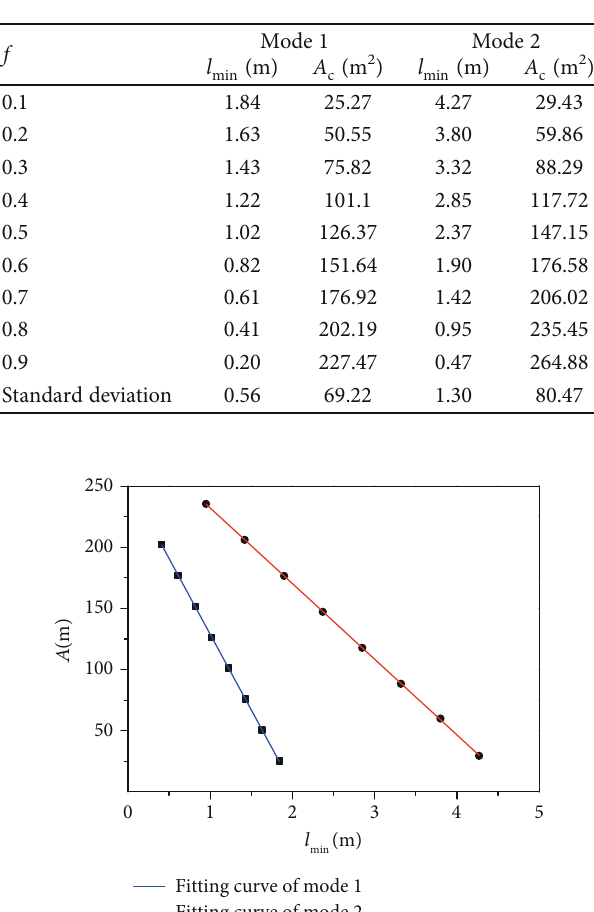
Table 6: Minimum length of the sewage double-pipe heat exchanger and the solar collector area under the di ff erent solar fractions in di ff erent modes.